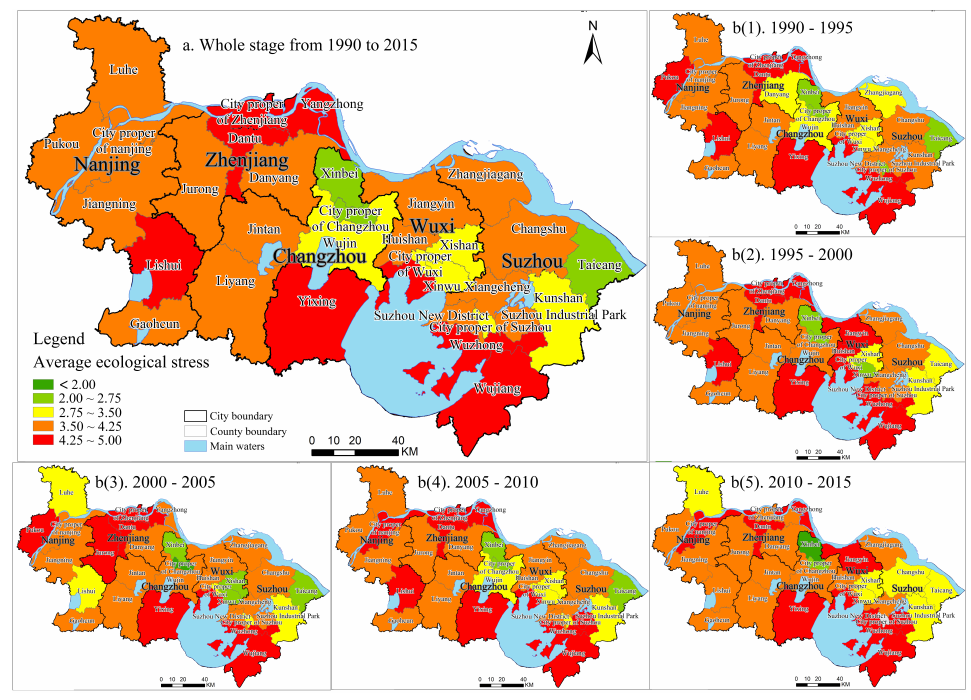
Figure 7. Spatial distributions of units with different ecological stress levels in each stage.